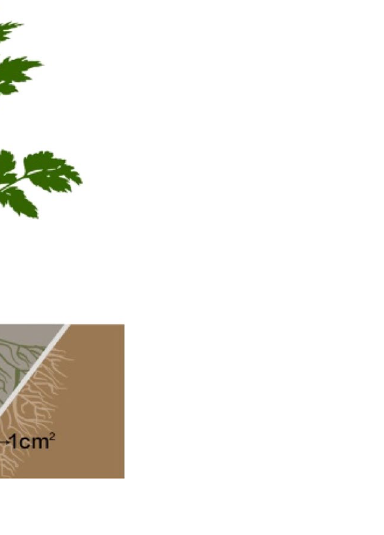
Figure 15. The model of conical soil